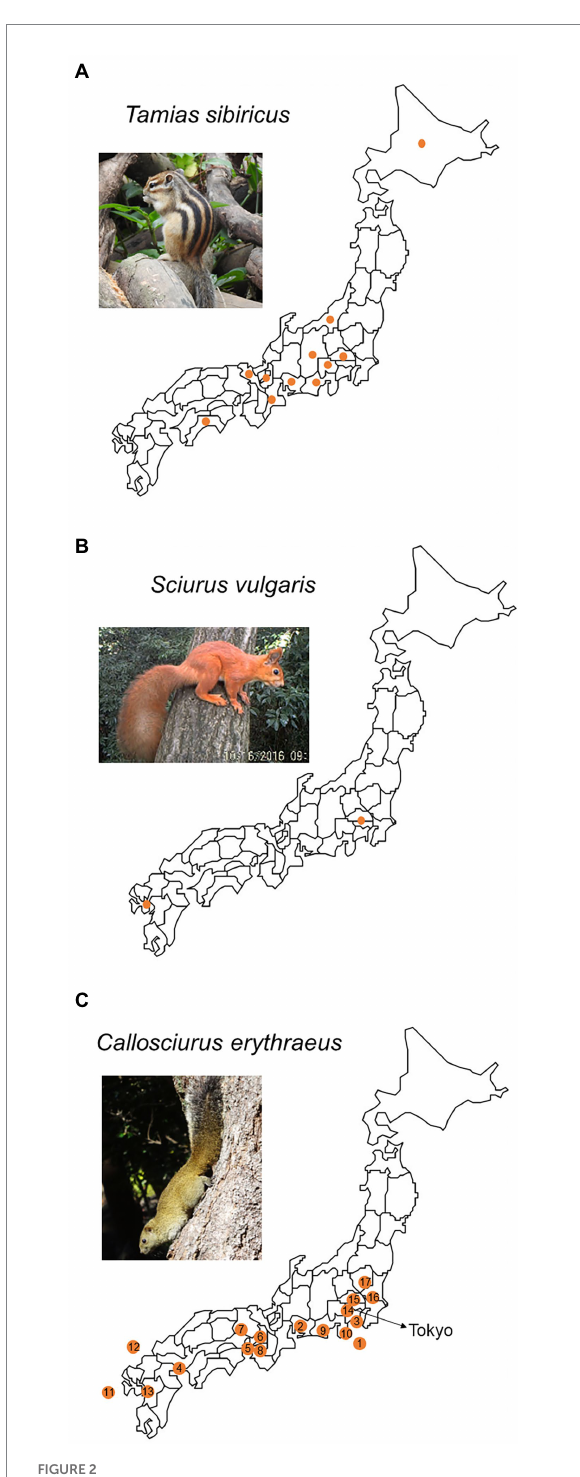
FIGURE 2 Distribution of nonindigenous squirrel species in Japan. Orange circles indicate that the species is present in the prefecture. (A) Tamias sibiricus is recorded in 7 prefectures including Hokkaido. (B) Sciurus vulgaris is recorded in Sayama Hills (border of Tokyo and Saitama Prefecture) and Nagasaki Prefecture. (C) Callosciurus erythraeus is recorded in 13 prefectures (the number corresponds to those in Table 1; Shikoku Institute of Natural History, 2002; Fukue, 2005; Mammal Society of Japan, 2017; Shiga Prefecture, 2019; Kyoto Prefecture,